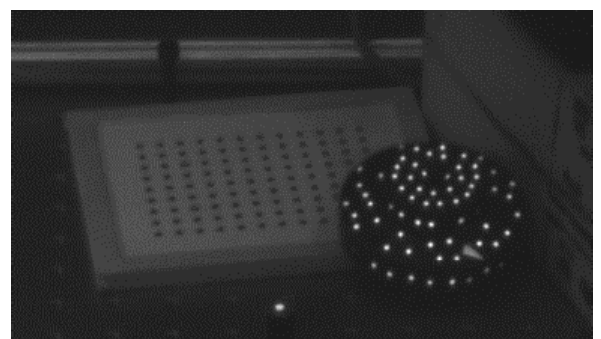
Figure 5. Large “Manhattan” calibration object